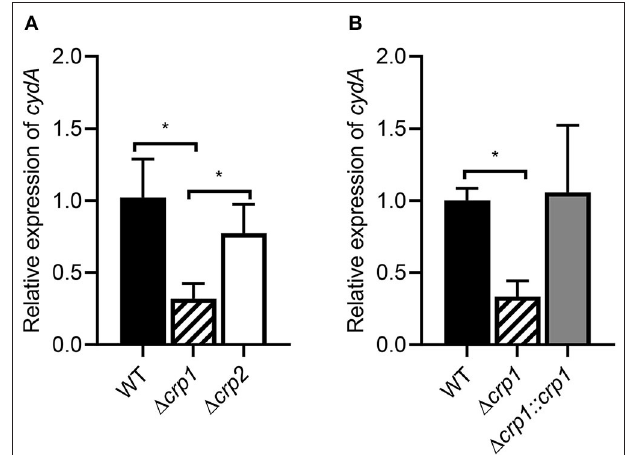
FIGURE 2 | Expression of the cydAB operon in the WT, 1 crp1 , and 1 crp2 mutant strains of M. smegmatis . (A) The relative transcript level of cydA in the WT, 1 crp1 , and 1 crp2 mutant strains. (B) Complementation of the 1 crp1 mutant. For complementation of the 1 crp1 mutant, pMV306crp (a pMV306-derived plasmid carrying the intact crp1 gene and its own promoter) was introduced into the mutant. As control strains, the WT and 1 crp1 strains with the empty vector pMV306 were used in the experiment. All the strains were grown aerobically to an OD 600 of 0.45–0.5 and treated with 100 µ M KCN for 15min. The expression level of cydA was quantitatively determined by qRT-PCR and normalized to sigA (the gene for the principal sigma factor) expression. The expression level of cydA in the KCN-treated WT strain is set at 1, and the relative values are expressed for the mutant strains. All values provide are the average of the results from three biological replicates. The error bars indicate the standard deviations. Statistical significance was determined by two-tailed Student’s t -test. * p <